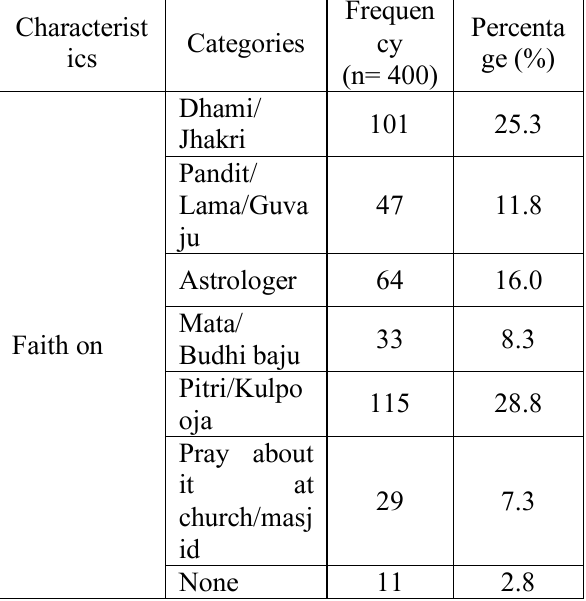
Table 2: shows most of the respondents